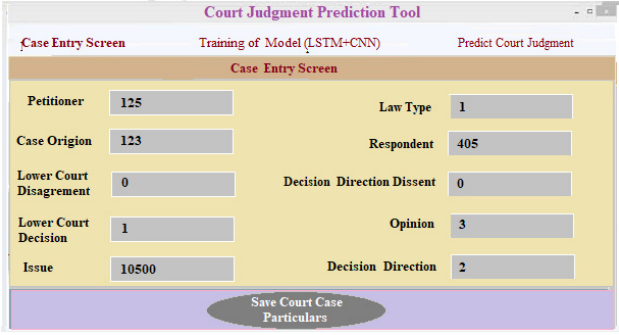
Figure 12. Application for entering data for court judgment prediction.